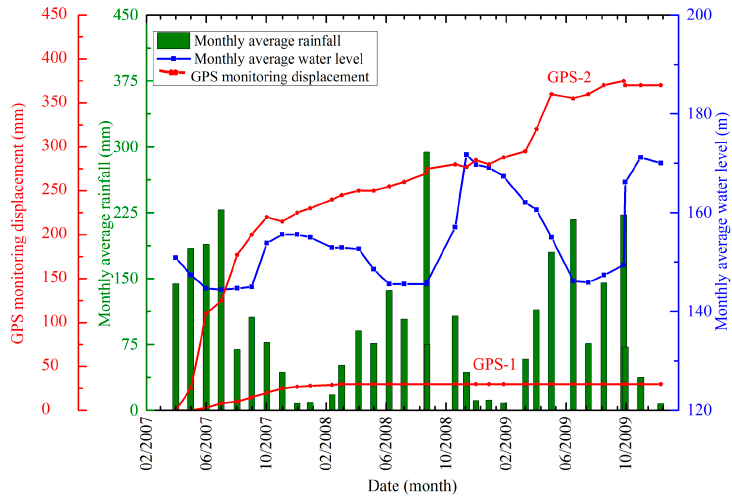
Figure 3. Curves of cumulative landslide displacement monitored by GPS.